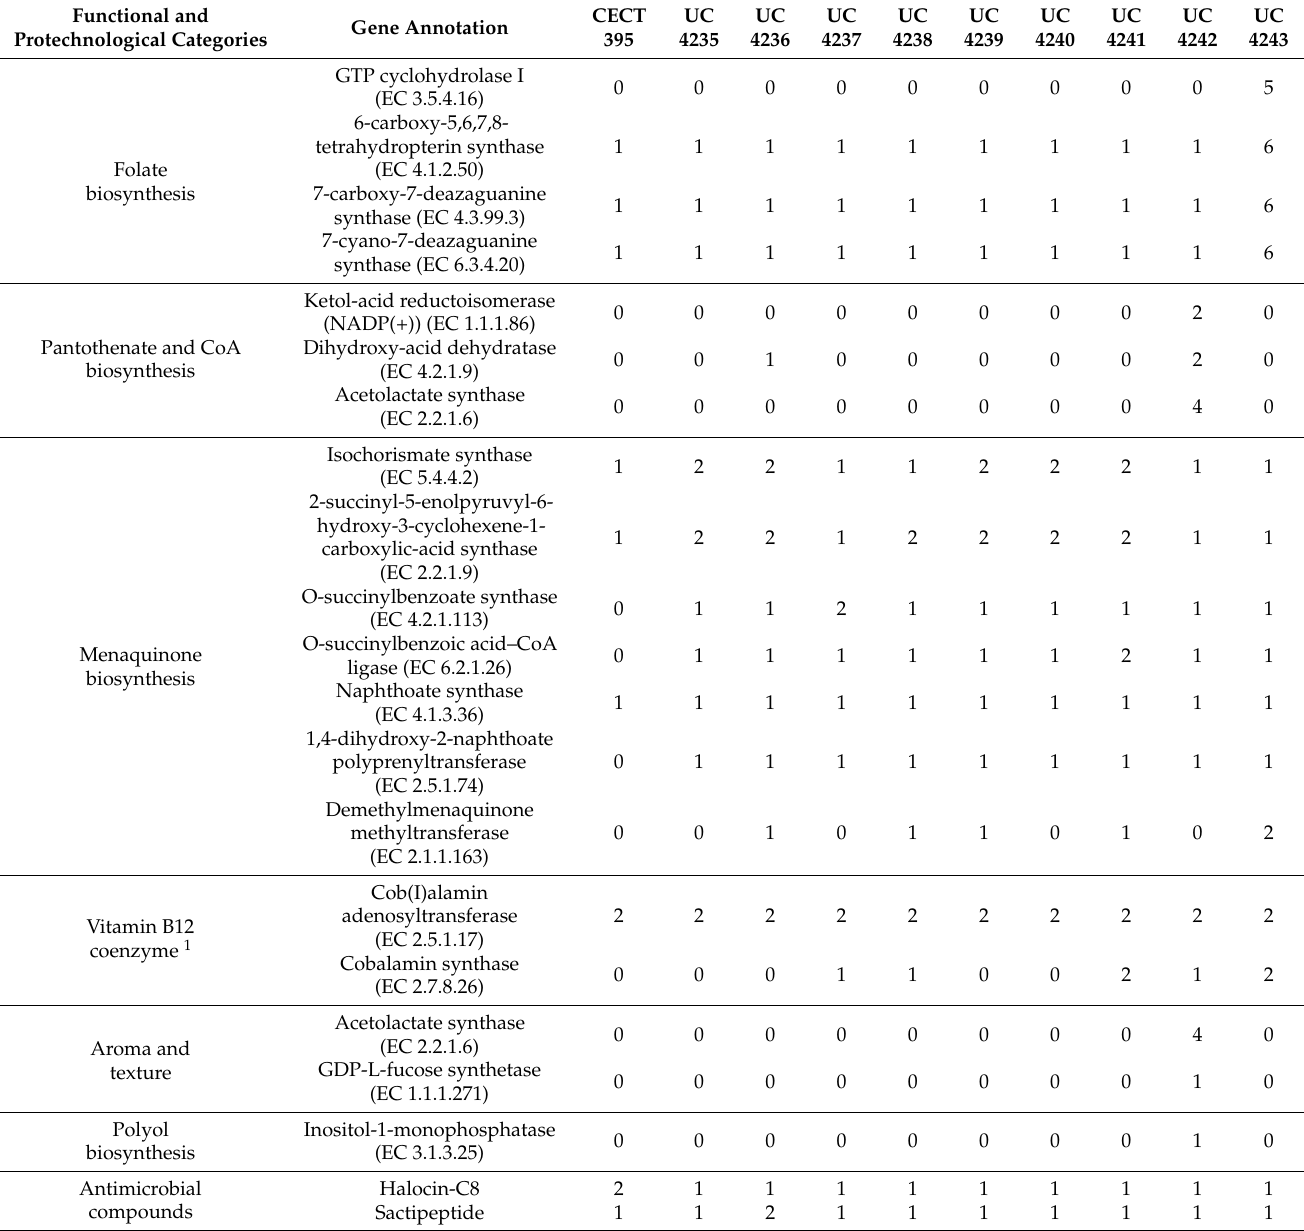
Table 2. Functional and protechnological genes in H. salinarum food